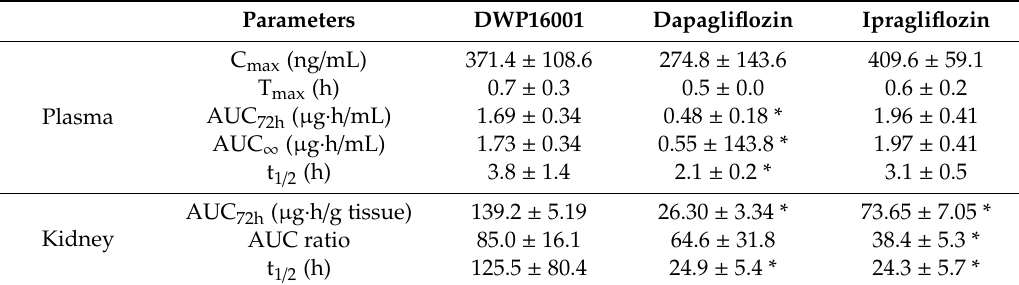
Area under curve (AUC) ratio: Ratios of Kidney AUC to plasma AUC; Data expressed as mean ± SD from five mice; * : p < 0.05, compared with DWP16001 group.